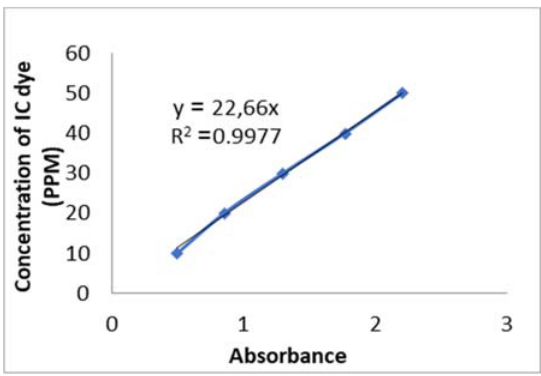
Fig. 2. Calibration curve of IC concentration